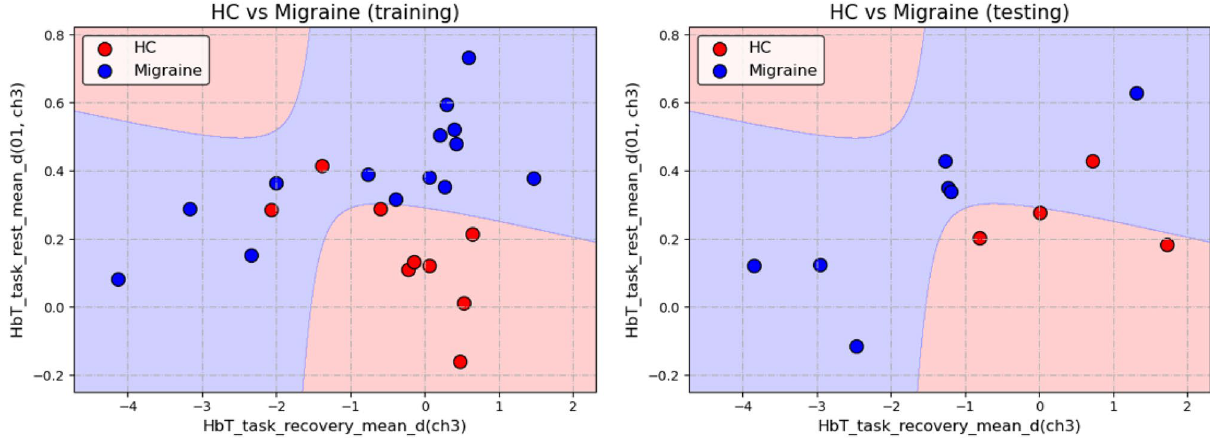
Figure 3. Results of Stepwise classification—classification of HC and